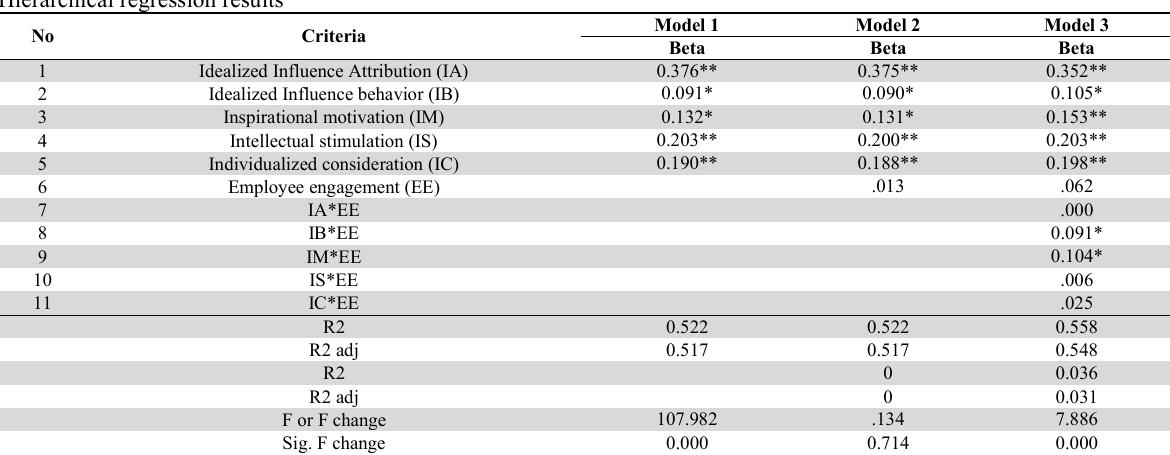
Hierarchical regression results